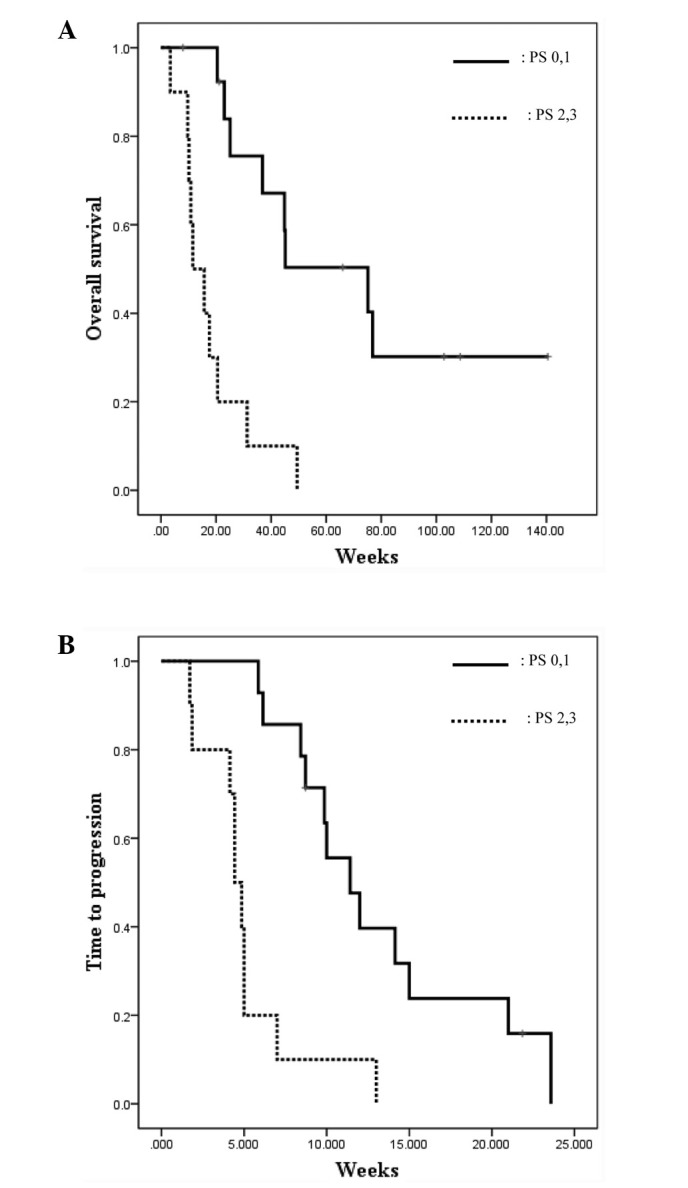
(A) Kaplan-Meier survival plots for OS and (B) TTP in advanced CRC treated with cetuximab monotherapy according to the performance status. OS, overall survival; TTP, time to progression; CRC, colorectal cancer; PS, performance status.